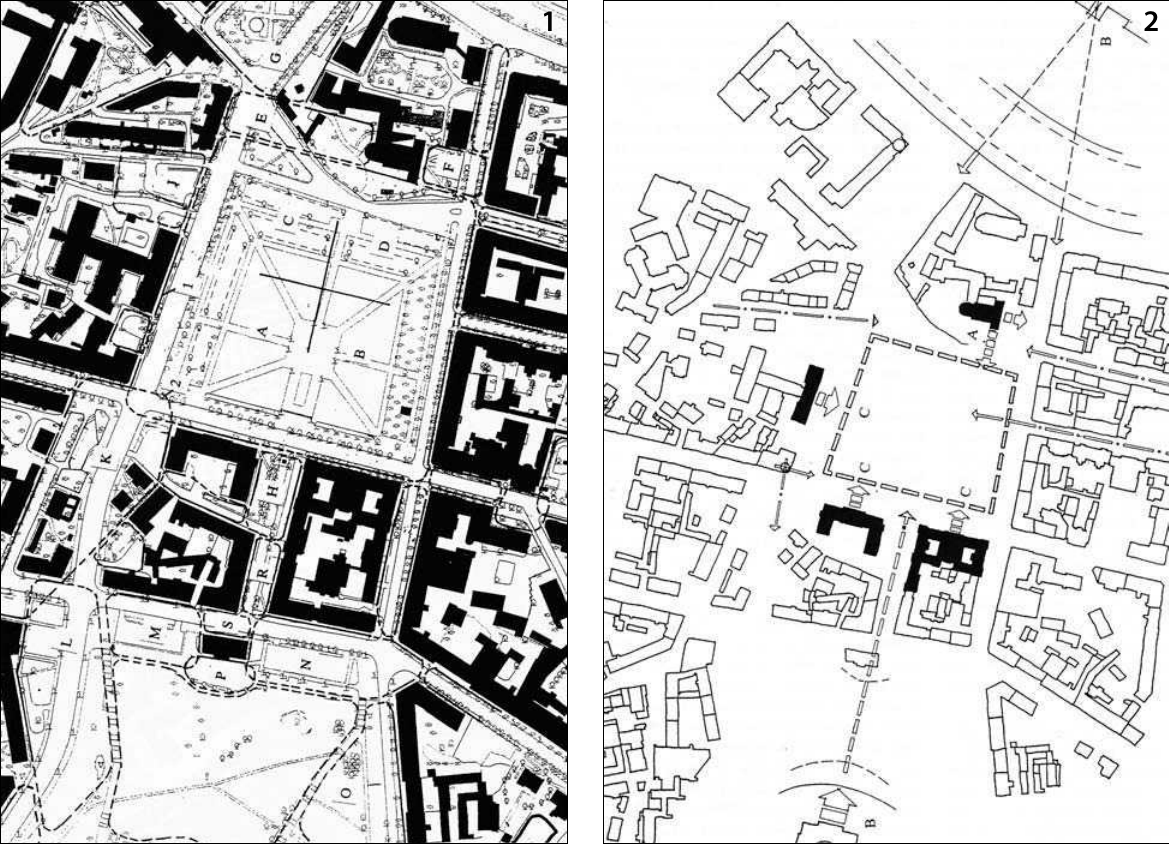
Fig. 11. Urban investigation of Lukiškės Square and its environment. Vilnius Gediminas Technical University, Dept of Urban Design, 1997: 1 – planning and spatial principles of Lukiškės Square and its environment; 2 – scheme of compositional axes of Lukiškės Square and its